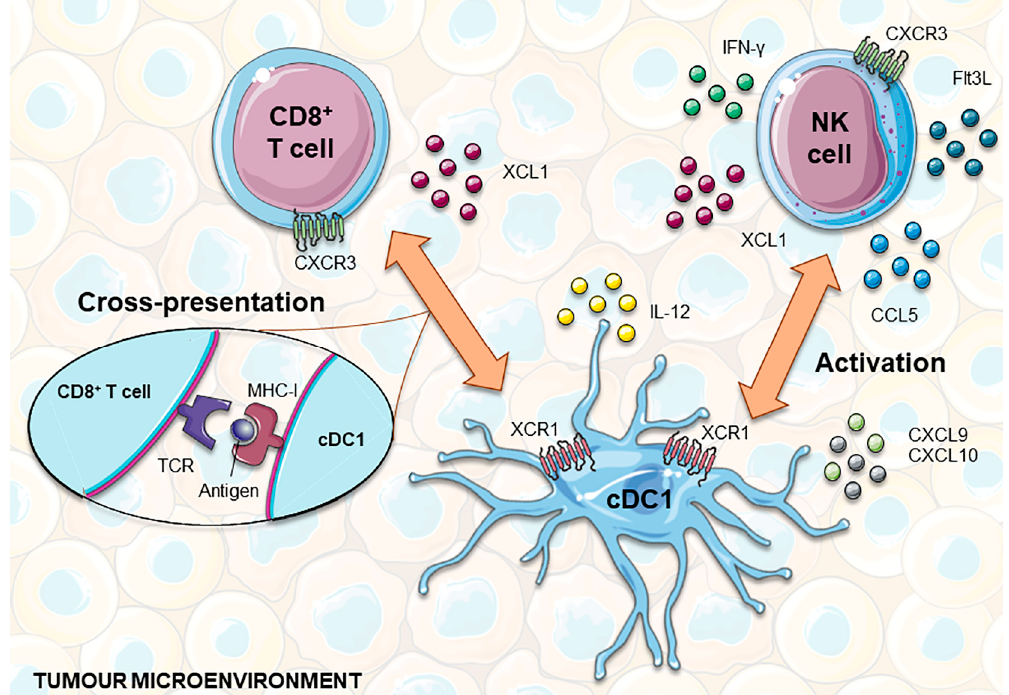
Figure 2. cDC1 interplay with CD8+ T and NK cells to develop anti-tumor responses. NK and CD8 + T cells express XCL1, which attracts XCR1 + cDC1 into the tumor microenvironment. In addition, NK cells can also produce CCL5, helping to recruit this subset of DCs. In turn, cDC1 are the main source of the chemokines CXCL9 and CXCL10, chemoattractants for T and NK cells. Functionally, cDC1 are highly capable of cross-presenting tumor antigens via MHC-I to CD8 + T cells and producing IL-12, which promotes T cell cytotoxicity and the production of INF- γ by NK cells. Furthermore, NK cells produce Flt3L that holds up the viability and functional capacities of cDC1 within the tumor microenvironment and can also promote their local differentiation from recruited precursors. cDC1, classical dendritic cell 1; Flt3L, FMS-like tyrosine kinase 3 ligand; IFN- γ , interferon gamma; MHC-I, major histocompatibility complex I; NK, natural killer; TCR, T cell receptor; XCL1, X-C Motif